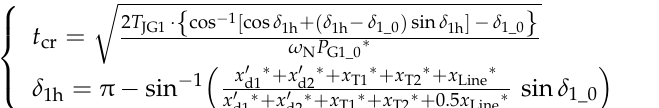
5 of 21 Figure 3. A typical two-area interconnected power system. ( a ) The wiring diagram. ( b ) The circuit diagram.